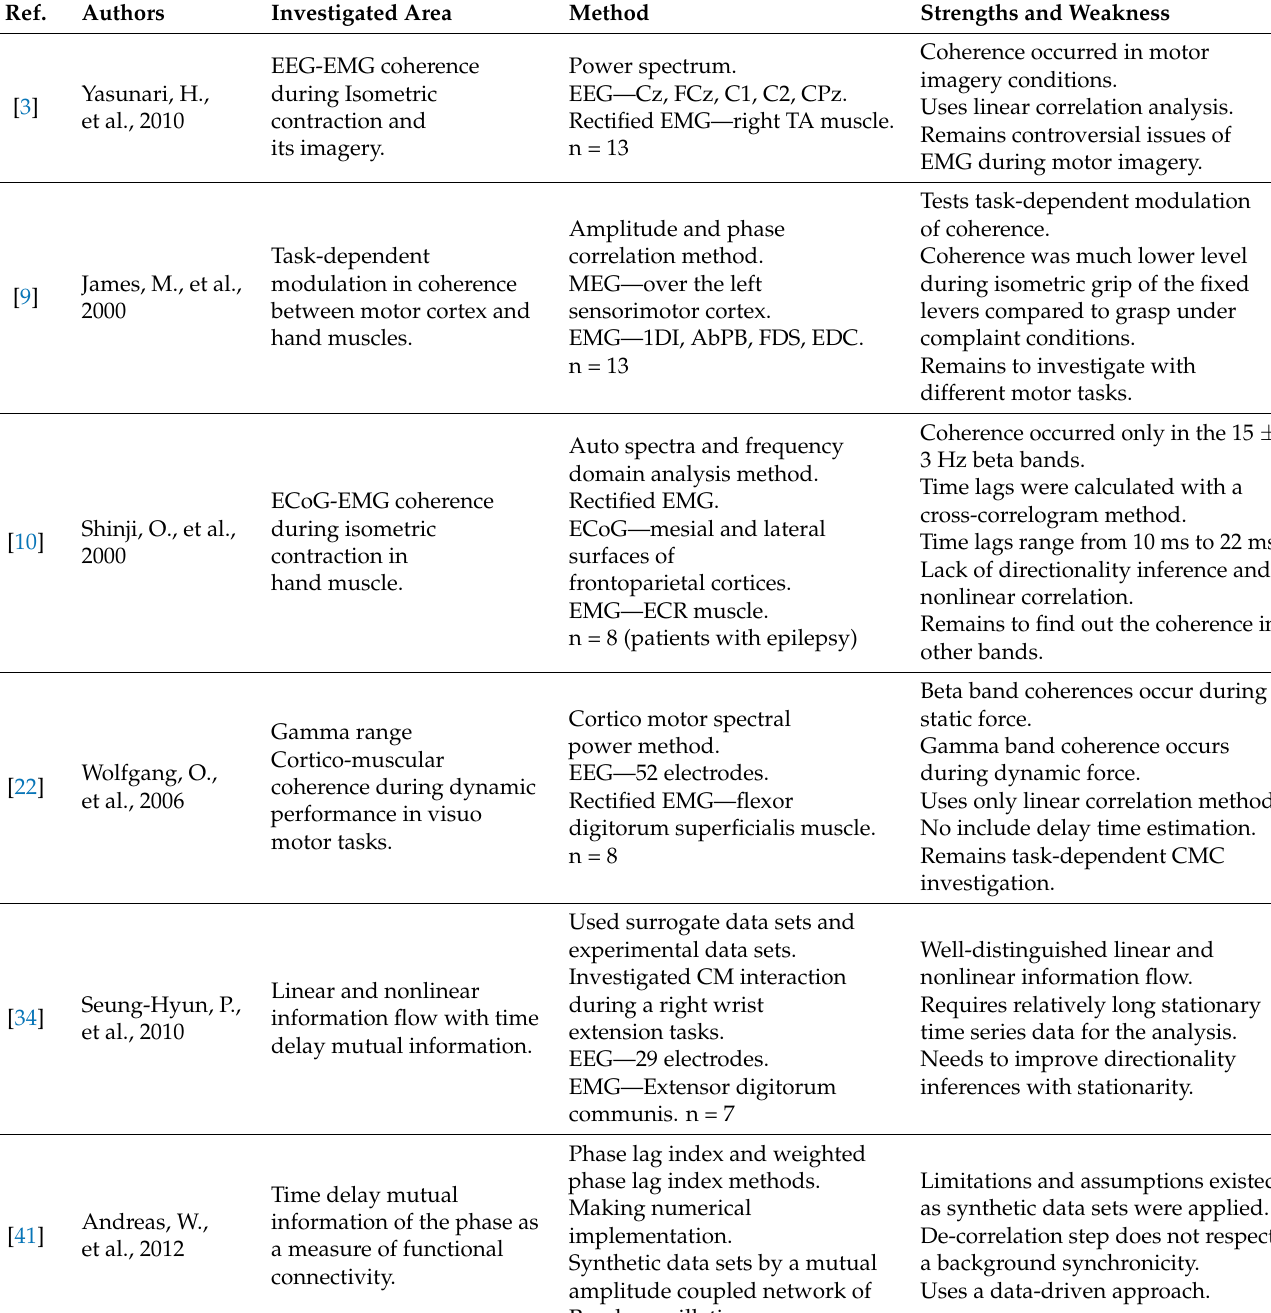
Table A1. Comparison table for different methods of the state of the art in functional coupling of EEG and EMG.